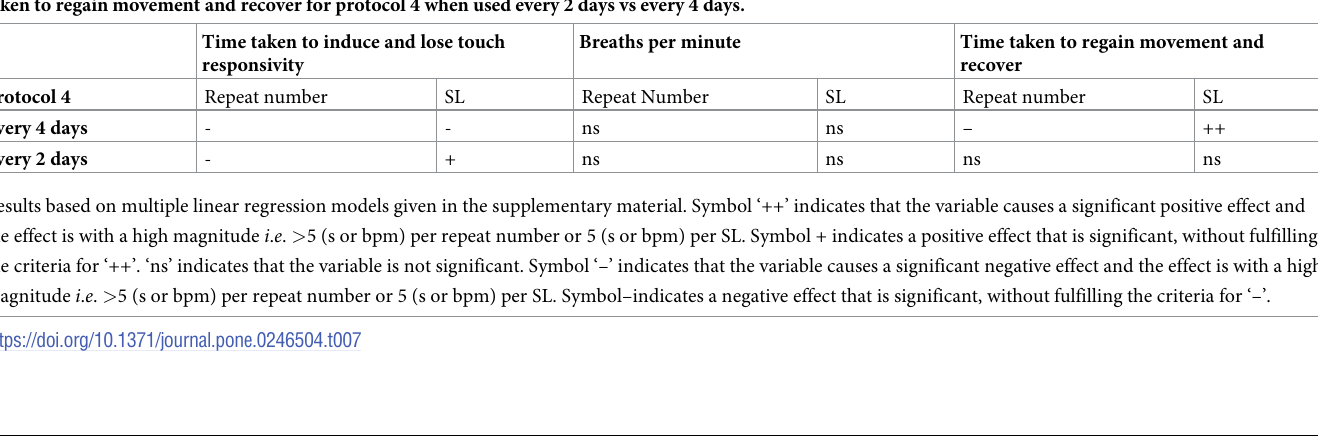
Zebrafish larvae and adult fish vary greatly in their response to anaesthetics due to their sig- nificantly different physiologies [31,32]. Adult zebrafish rely on their gills for oxygen absorp- tion. The usual cause of death for adult fish under anaesthesia is by asphyxiation, caused by the blockage of gill ventilation leading to hypoxemia [33,34]. Deeply anaesthetised adult fish can be kept alive for hours to days, but only if their gills are artificially ventilated [35]. Zebrafish larvae do not have gills and thus rely on cutaneous gas exchange for oxygen absorption. Zebra- fish larvae, as a result, are considerably more tolerant to the lethal effects of MS-222 than adult fish [36].